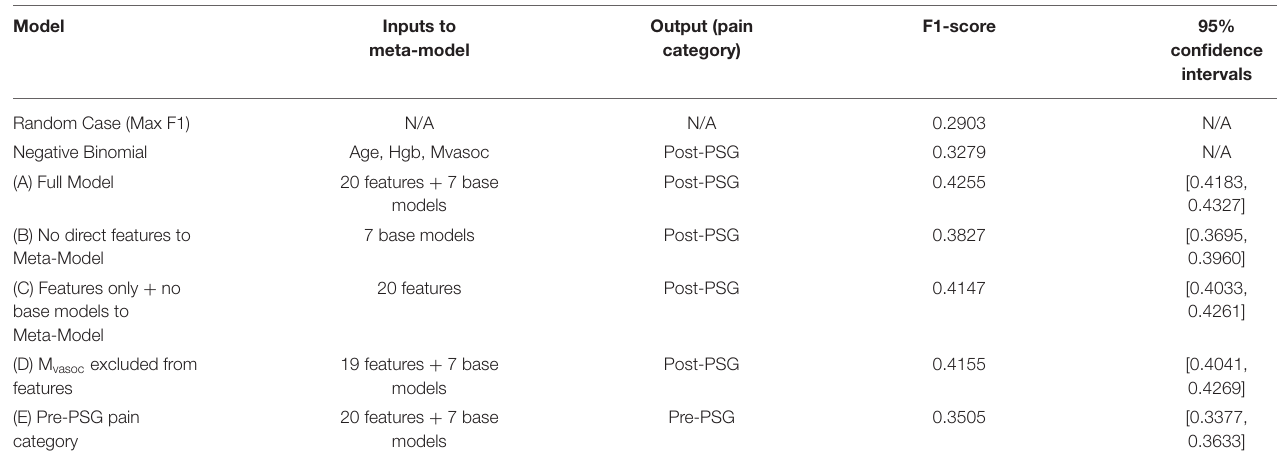
TABLE 3 | Model performance